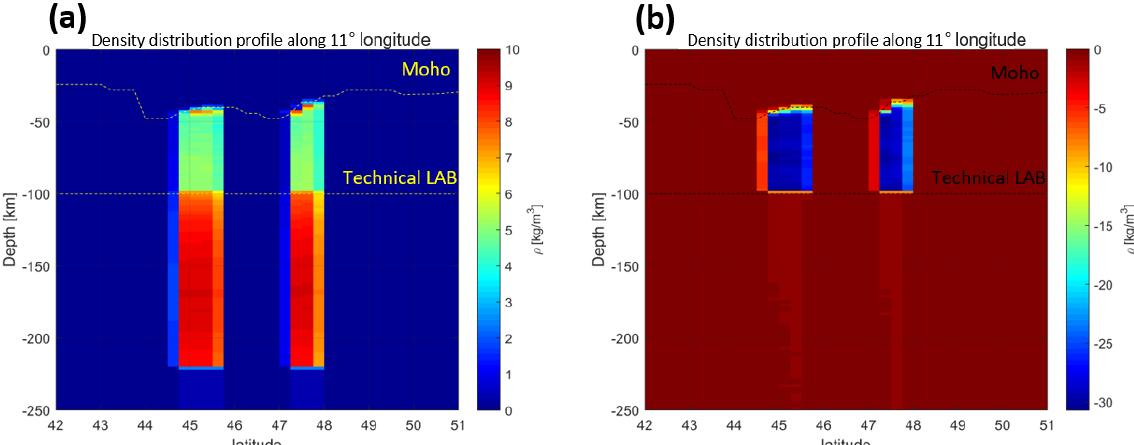
Figure 10. (a) Residual density contrast for lithospheric and sublithospheric slab segments of model ( M 3 ) with Tecton-like composition within the lithosphere and PUM and DMM composition in the sublithosphere with an additional thermal anomaly of − 100K for the sub- lithospheric slab segment to the background model ( M 0 ). (b) Residual lithospheric density contrast of a Proterozoic lithospheric slab segment ( M 8 ) to a Tecton compositional surrounding mantle ( M 0 ). Residual density contrast is limited to the technical LAB as the sublithospheric part is identical to the reference model (see also Fig.